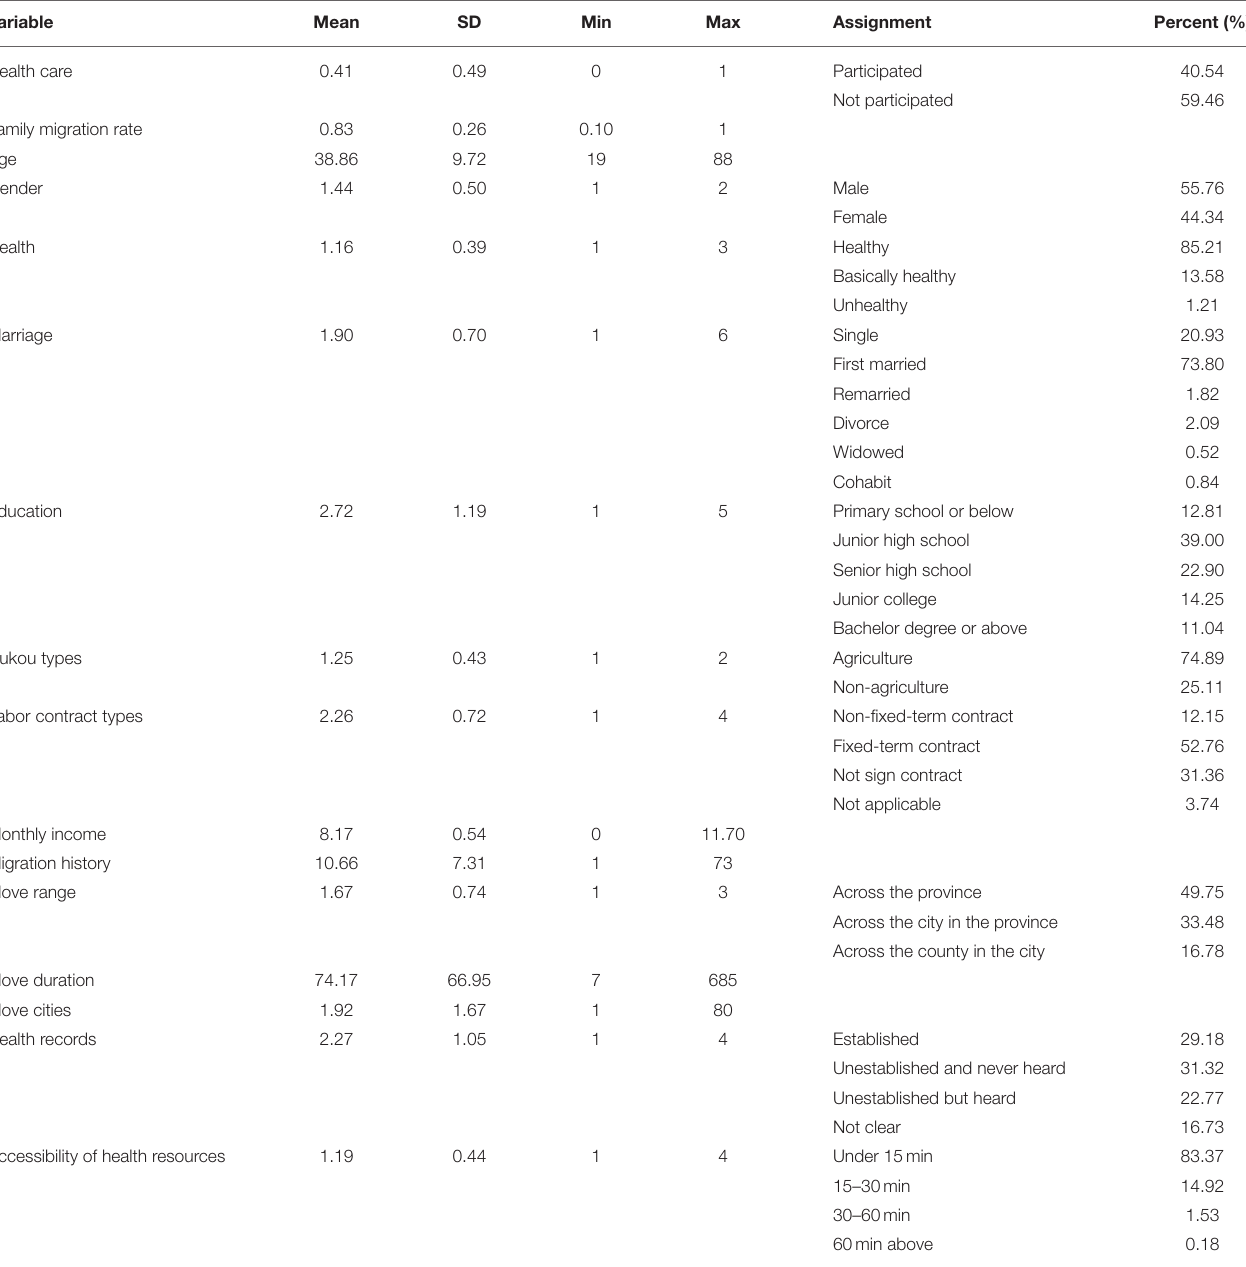
TABLE 2 | Descriptive statistics of variables ( N =